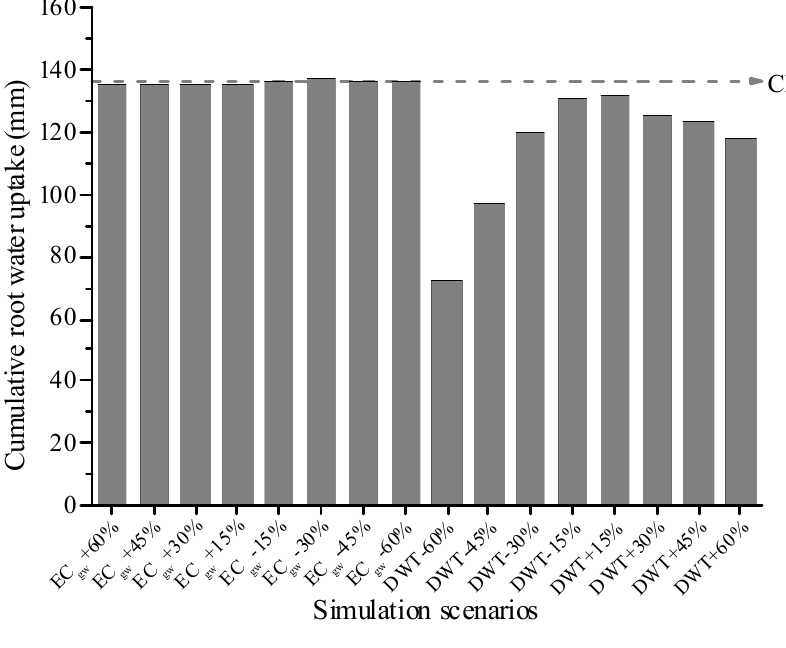
Figure 6. Cumulative root water uptake of Chinese tamarisk under different simulation conditions. CK is cumulative root water uptake of 2012 growing